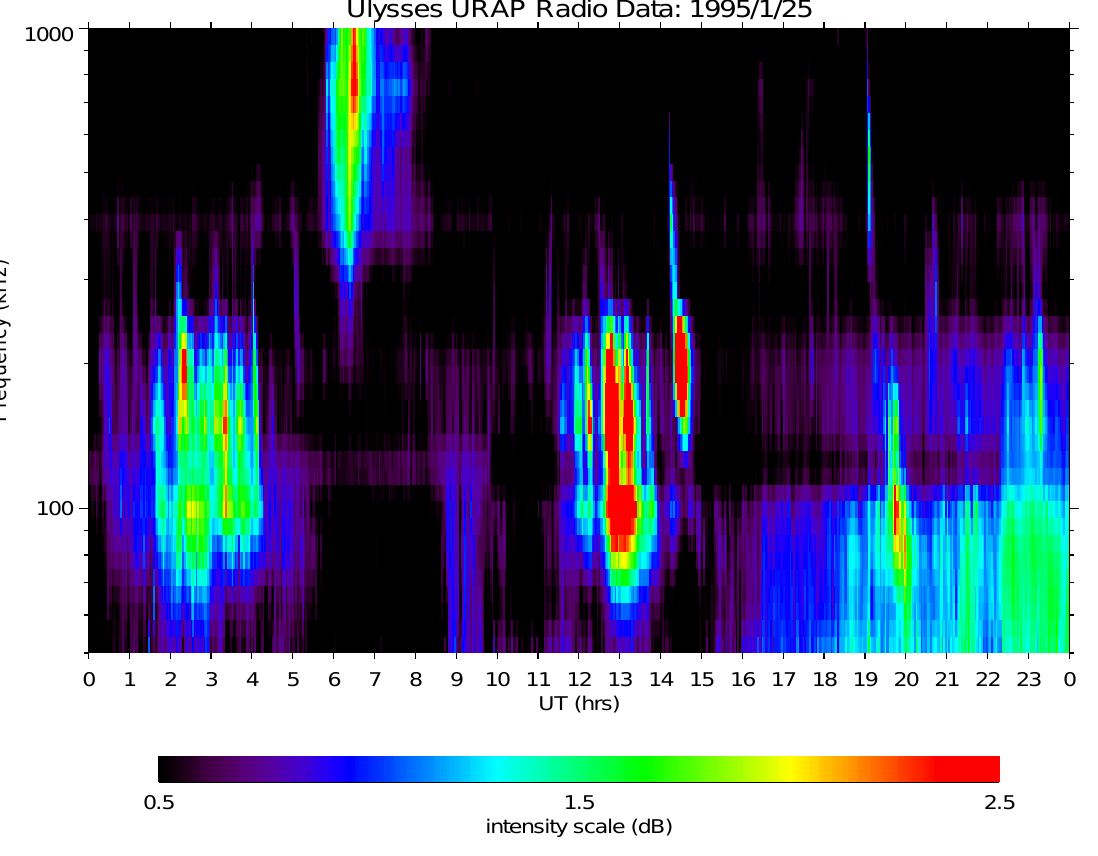
Fig. 2. Ulysses/URAP hi-band spectrum for 950125 (DOY 94390).